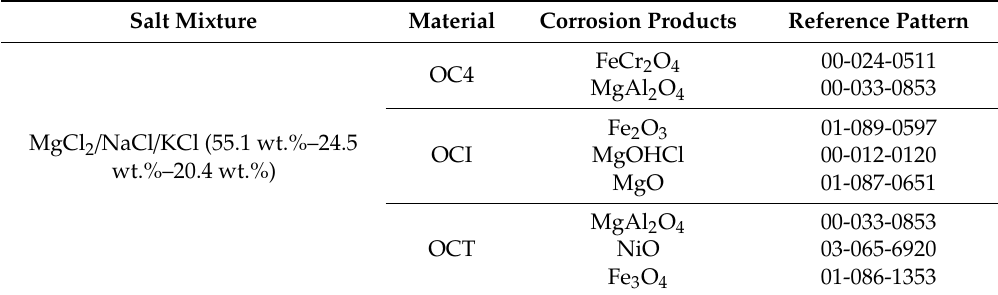
Figure 9. XRD analysis of OCT after 8 h of immersion in 20.4 wt.% KCl + 55.1 wt.% MgCl 2 + 24.5 wt.% NaCl at 720ºC. Table 6. Corrosion products identified by XRD analysis on OC4, OCI, and OCT after immersion in chloride molten salt at 720 ◦ C for 8